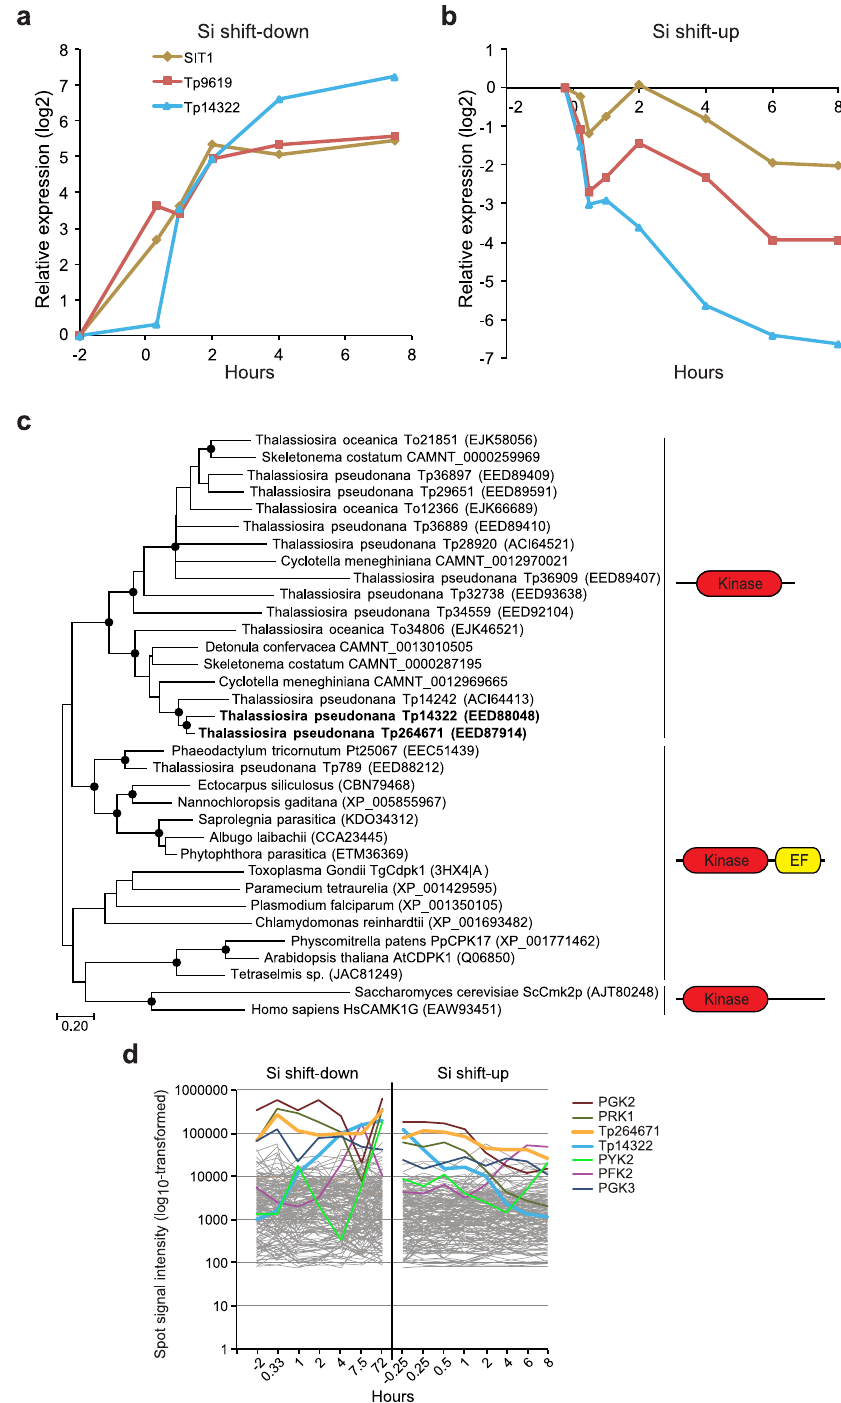
Figure 5. A highly expressed kinase is coexpressed with the silicon transporter SIT1. ( a – b ) Expression of the SIT1 gene cluster represented as log2-transformed fold change during ( a ) Si shift-down and ( b ) Si shift-up. ( c ) Maximum likelihood (ML) and neighbour-joining (N-J) trees were constructed based on a protein alignment of Tp14322 and Tp264671 (shown in bold) and related kinases. The ML tree is shown. The overall topologies for the N-J and ML trees are the same. Black circles indicate nodes supported by ML and NJ bootstrap values (1000 × sampling) > 90%. GenBank accession numbers are given in brackets. Domain composition of the different clades is shown to the right. ( d ) Expression levels of differentially expressed kinase-encoding genes during the Si experiments. Expression values are log10 transformed. The seven kinase-encoding genes with highest expression levels are shown in coloured lines, and are listed to the right from top to bottom based on maximum expression level. Tp14322 and Tp264671 are shown in bold lines. PFK, phosphofructokinase; PGK, phosphoglycerate kinase; PRK, phosphoribulokinase; PYK, pyruvate